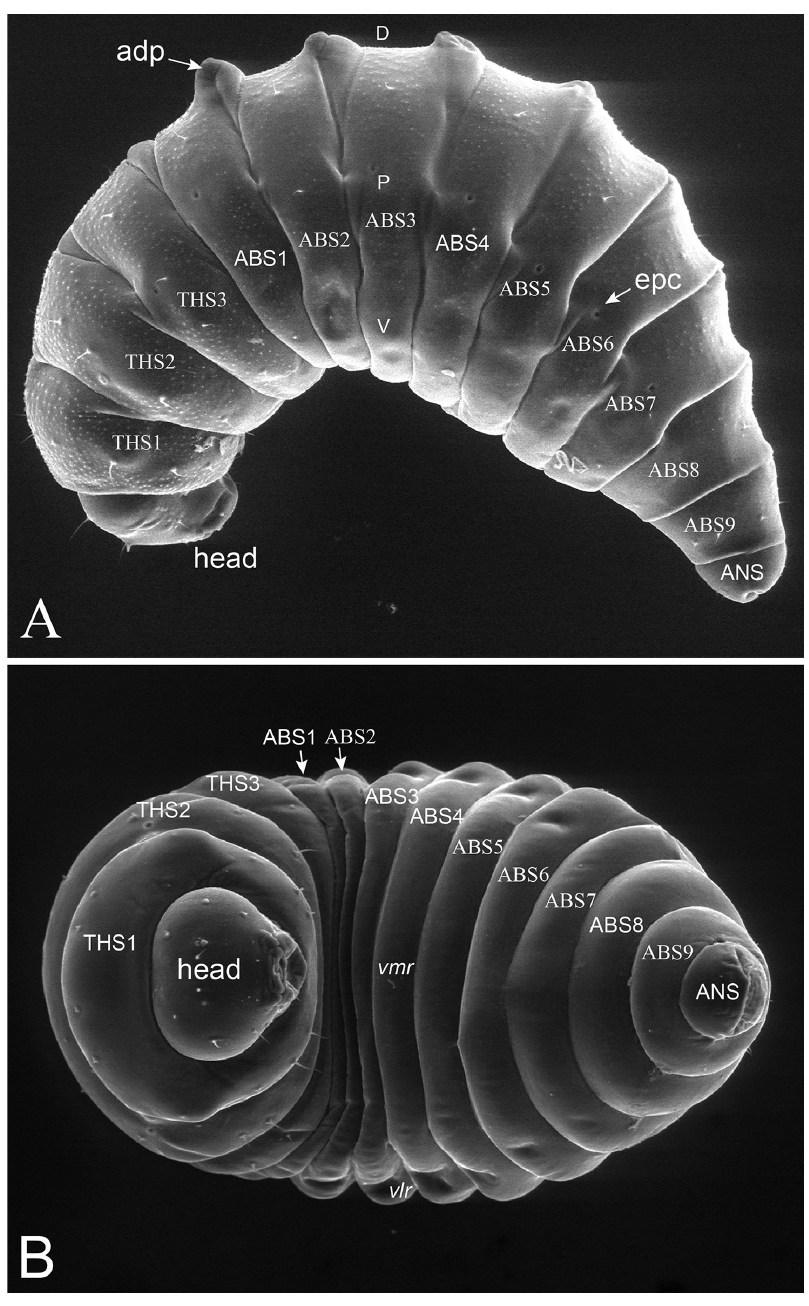
Figure 1. General morphology of body. A Lateral view of Ormyrus cupreus B ventral view of Ormyrus diffinis . Letters refer to the terminology used for general description (see text): ABS1-ABS9 , abdominal segments; adp , anterodorsal protuberances; ANS , anal segment; THS1-THS3 , thoracic segments; D , dor- sal; P , pleural; V , ventral; vlr , ventrolateral region; vmr , ventromedial